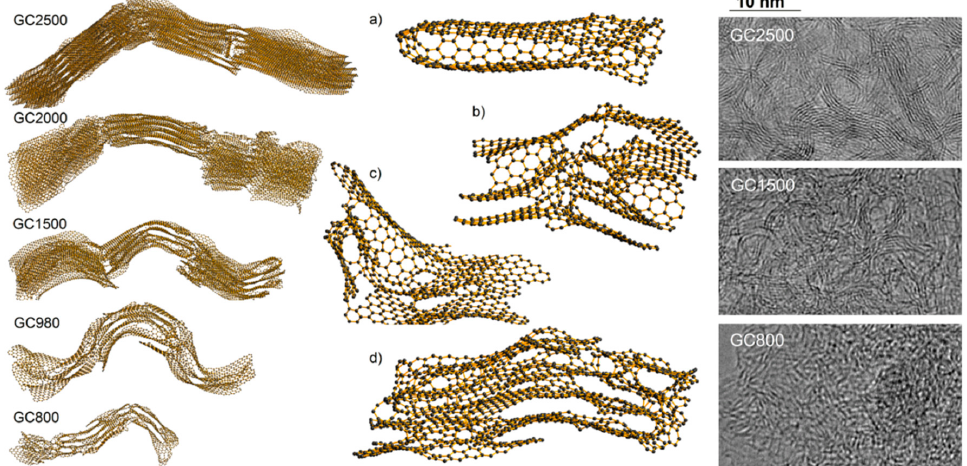
Figure 26. Structural models for polyfurfuryl alcohol-based glass-like carbons pyrolysed at temperatures: 2500, 2000, 1500, 980, and 800 ◦ C, composed of several coherent scattering domains connected to each other (on the left). ( a – d ) Selected fragments of the models showing curved fullerene-like or nanotube-like elements. Reproduced with permission from Jurkiewicz et al. [26]. Copyright International Union of Crystallography, 2017. HRTEM images of glass-like carbons prepared at 2500, 1500, and 800 ◦ C (on the right) obtained with the S/TEM Titan 80–300 microscope at accelerating voltage of 300